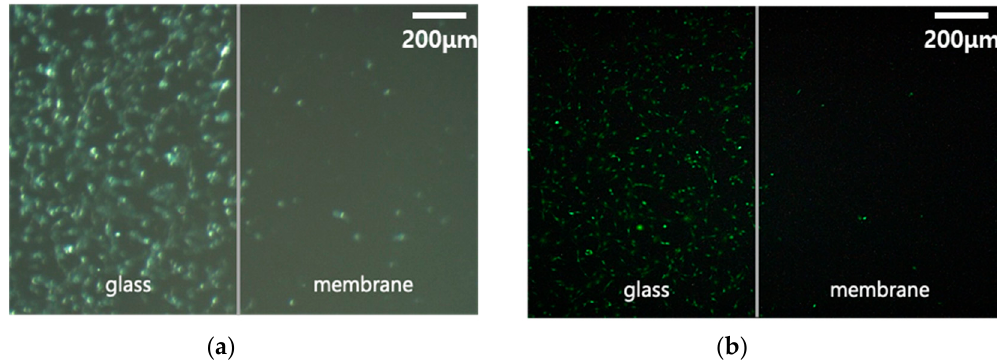
Figure 6. The results obtained from the anti-adhesion test in this study. ( a ) bright-field and ( b ) confocal microscopy.